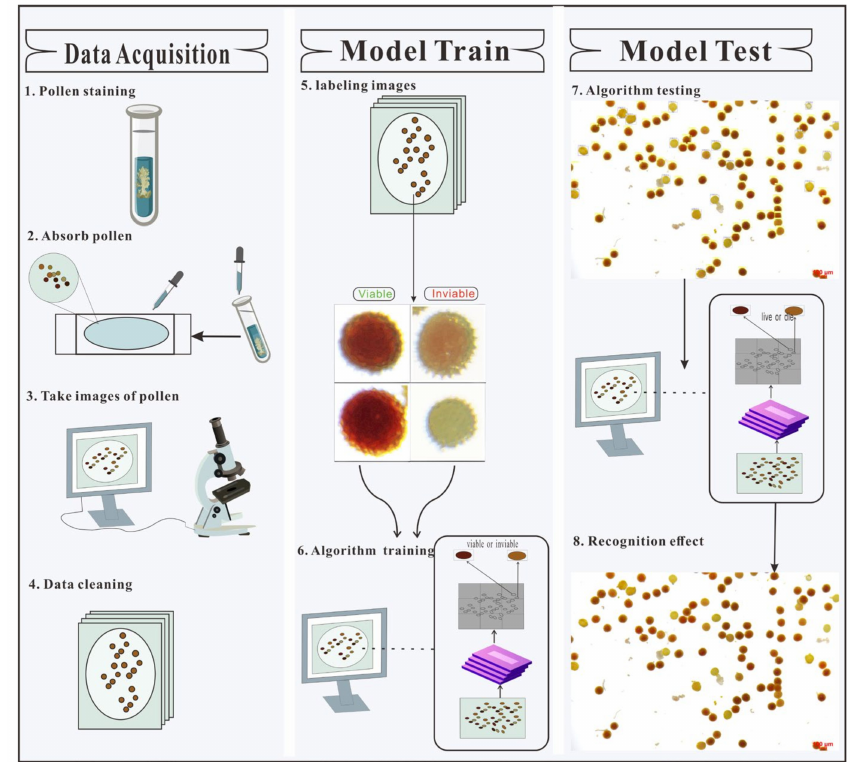
Figure 1. Pipeline for algorithm development. (1) The pollen was placed in TTC solution for 1 h. (2) The supernatant was absorbed and placed on a glass slide. (3) The cotton pollen image was taken under a binocular microscope with a camera. (4) The captured pollen image was cleaned and the unclear images were removed. (5) The cleaned pollen image was marked with image marking software to distinguish viable and nonviable pollen. (6) Pollen images and tagging files were fed into the deep learning model for training. (7) A set of new images was sent to the trained deep learning model for detection to evaluate model performance and select the best model. (8) Each pollen grain was marked with its category in the detected